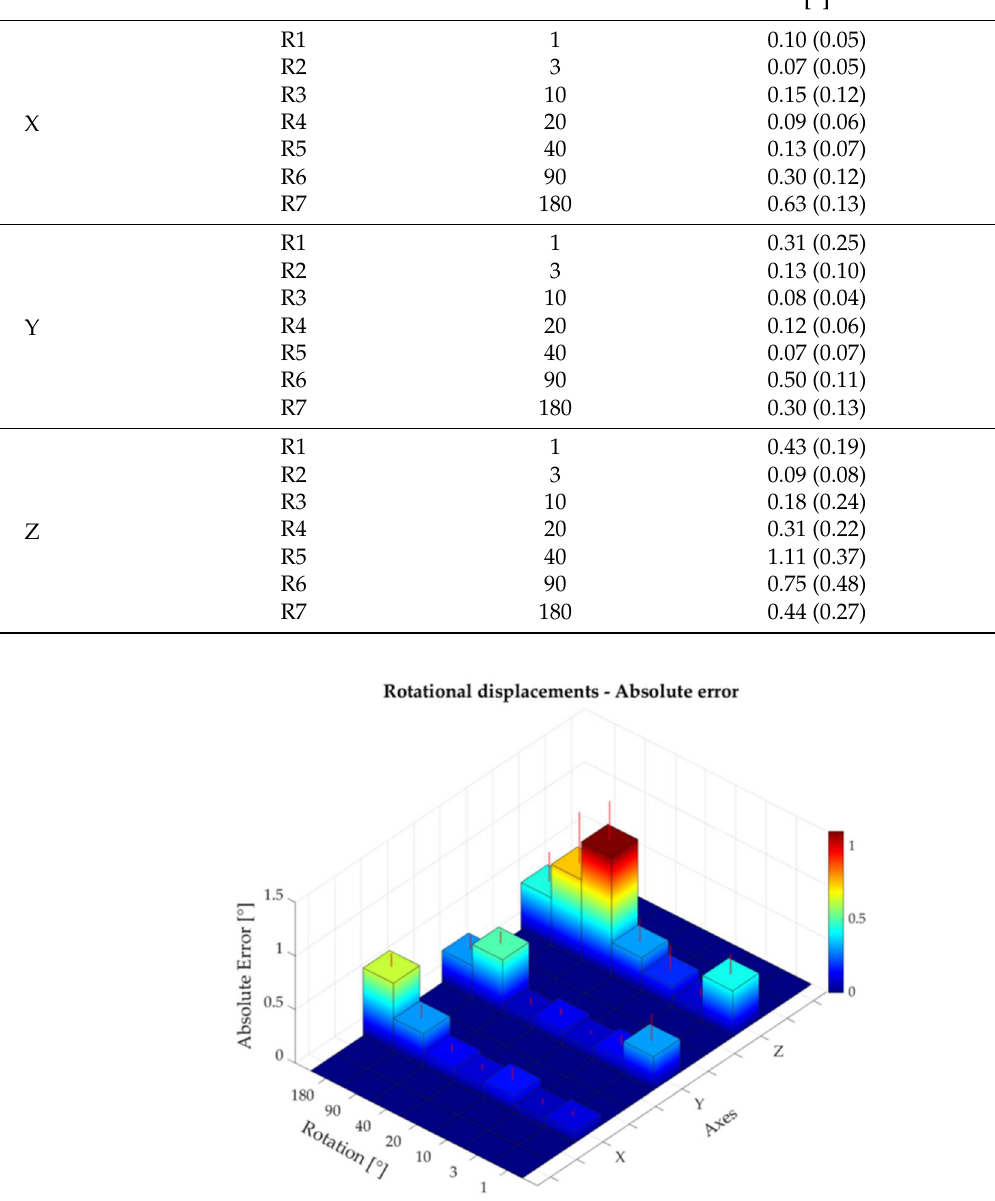
Figure 10. The percentage error corresponding to rotational displacements around the x-, y-, and z-axes. Figure 11. Bland–Altman plots comparing t he rotational displacements measured by the Qualisys Optical Motion Capture (OMC) system and by the Controller A of the Oculus Quest 2.